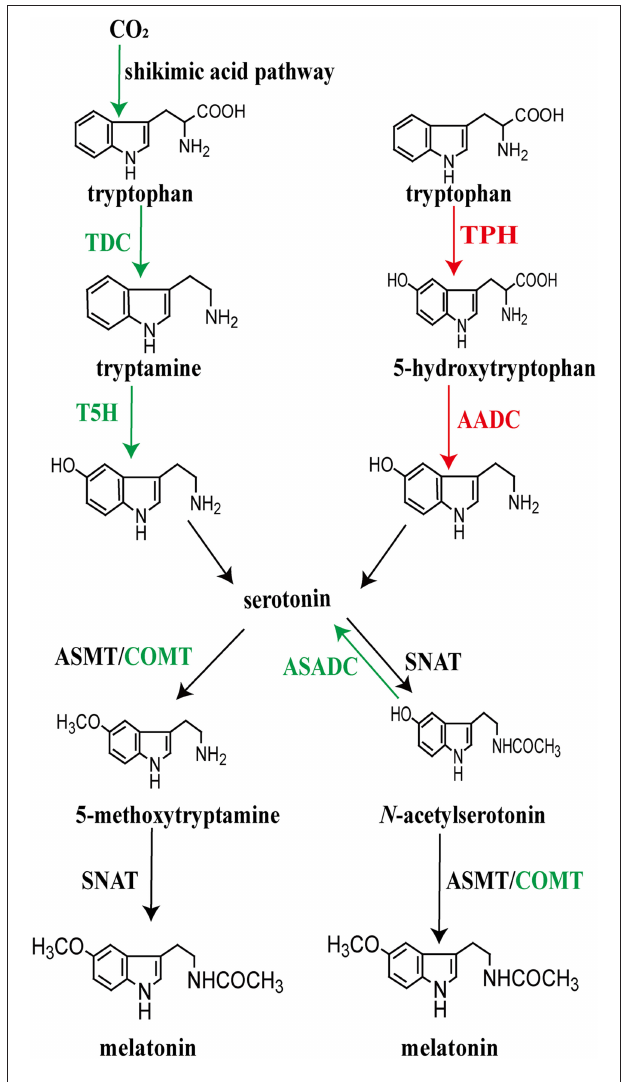
FIGURE 4 | Pathways of melatonin synthesis in different plant (left) and animal (right) taxa. Depending on the organism, not all of the events necessarily take place in the chloroplasts or mitochondria of every species. For the species, plant and animal, that have been investigated, the published data provide strong evidence that these organelles are critically involved with melatonin